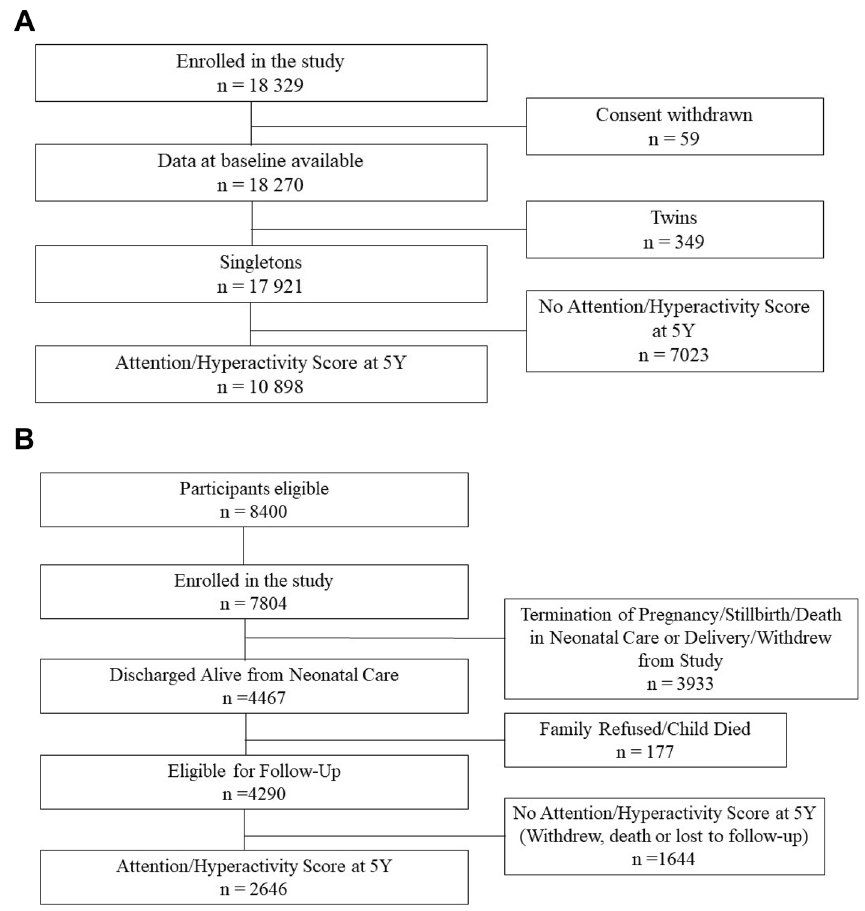
Figure 1. ( A ) Flowchart of study participation in the ELFE cohort study. ( B ) Flowchart of study participation in the EPIPAGE 2 cohort